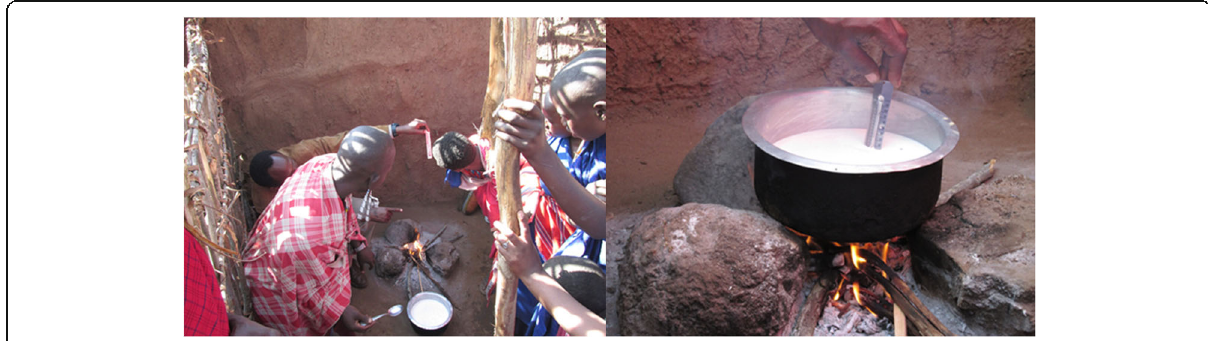
Fig. 1 Training Maasai women how to pasteurize milk in